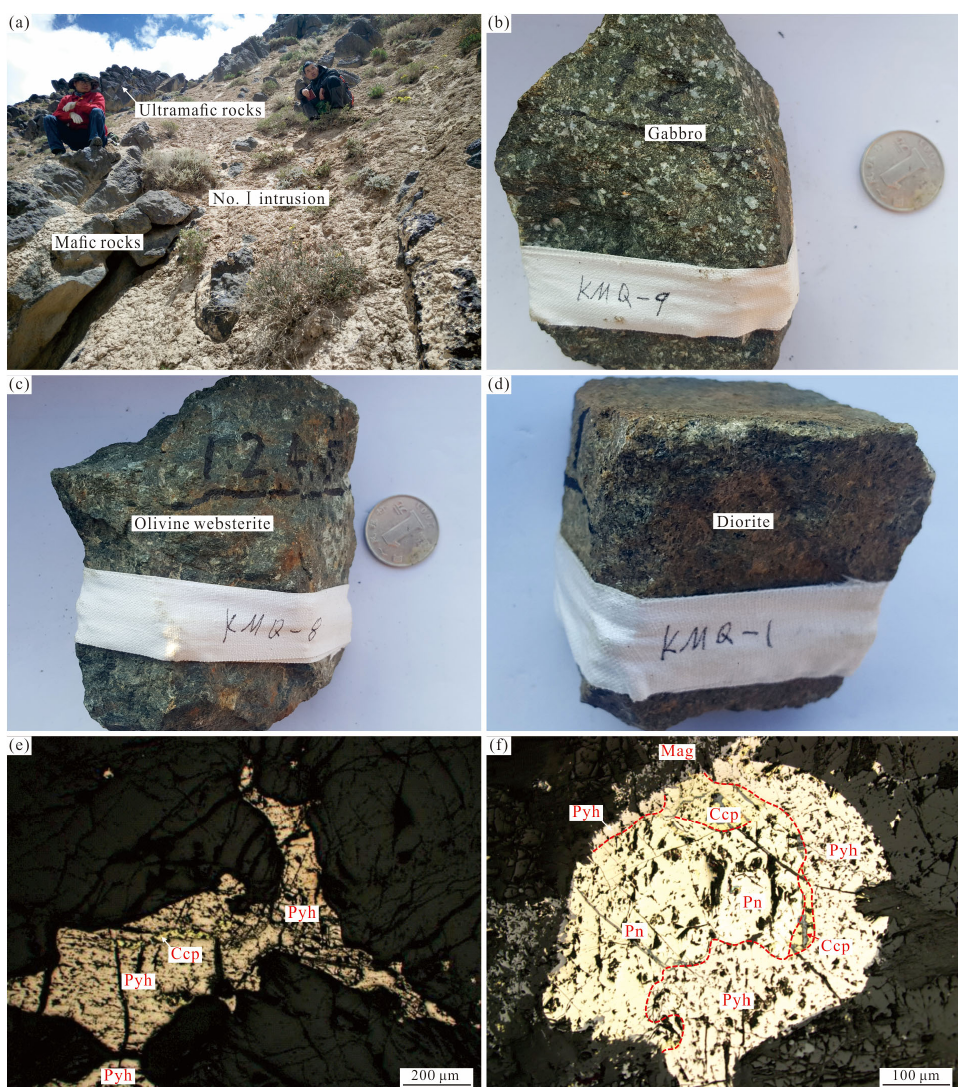
Figure 3. ( a ) Field photographs of the No. Ⅰ mafic–ultramafic complex. ( b ) Hand specimen of gabbro. ( c ) Hand specimen of olivine websterite. ( d ) Hand specimen of diorite. ( e , f ) Representative photomicrographs of the major metallic minerals (plane ‐ polarized reflected light). The mineral abbreviations are after [39]: Pyh–pyrrhotite, Ccp–chalcopyrite, Mag–magnetite, Pn–pentlandite.